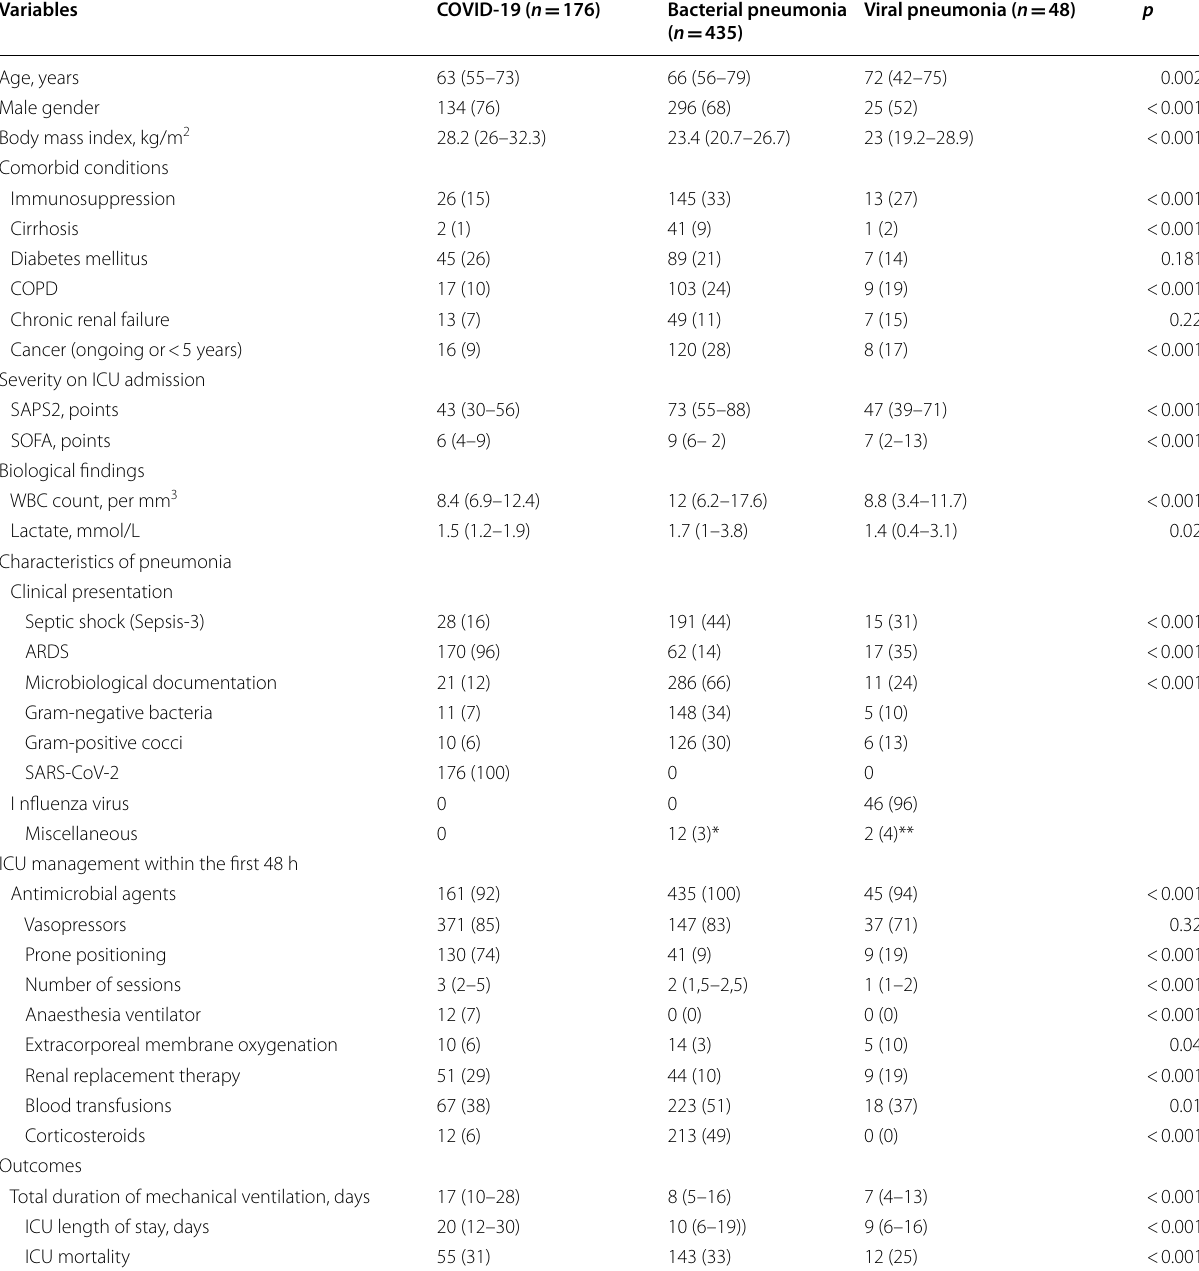
Table 1 Characteristics and outcome of patients with COVID-19, bacterial pneumonia or viral